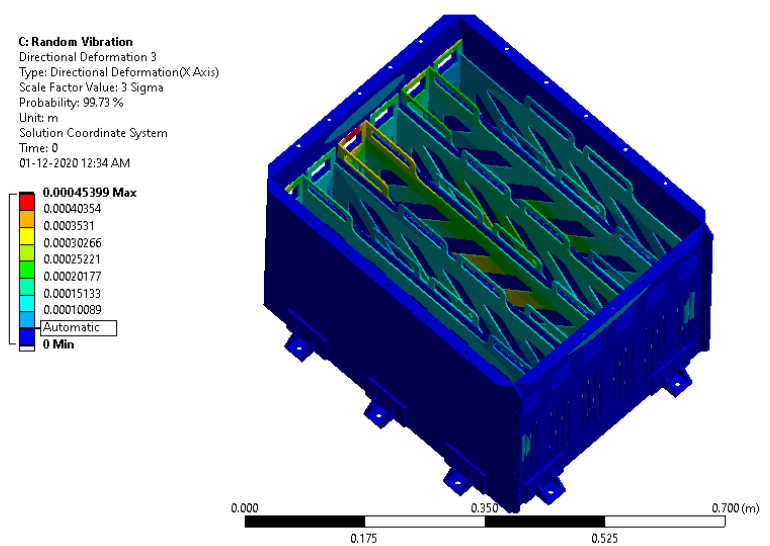
As the probability of the sigma 3 scale factor is the highest, it is hence considered for total directional deformation and equivalent Von Mises stress. The results of directional deformation of scale factors sigma 3 are shown in Figure 19.